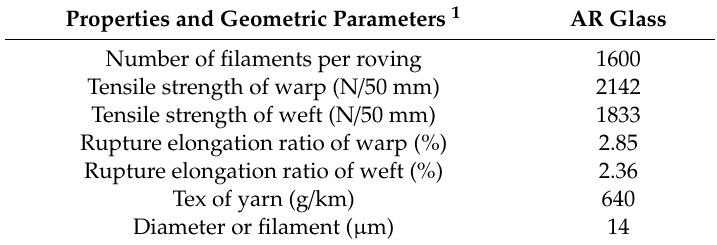
Table 1. Detailed specifications of the AR glass provided by the manufacturer; AR: Alkali Resistant.